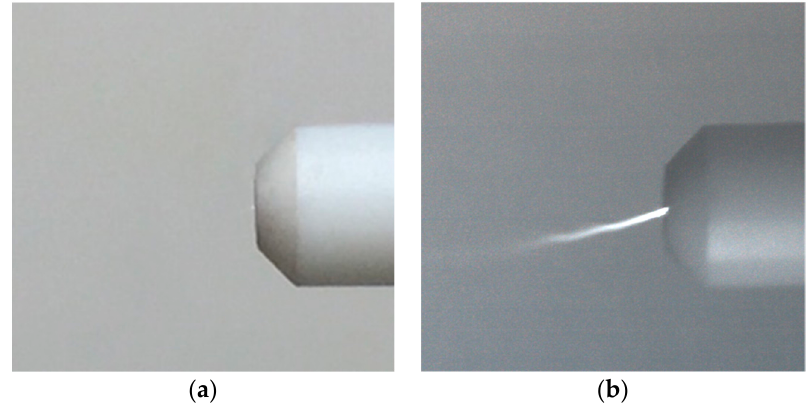
Figure 13. Images of corona discharge taken by an ordinary CIS ( a ) and an OPF imager ( b ).